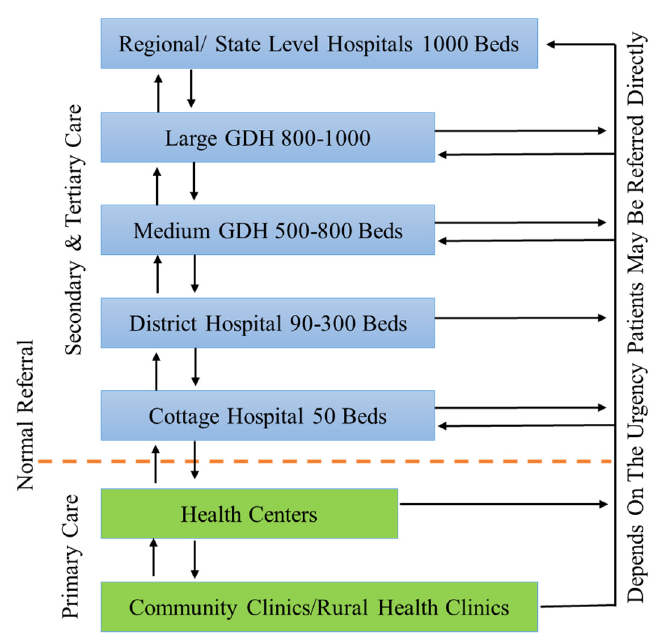
Figure 1. The referral system in the Malaysian healthcare system [29].